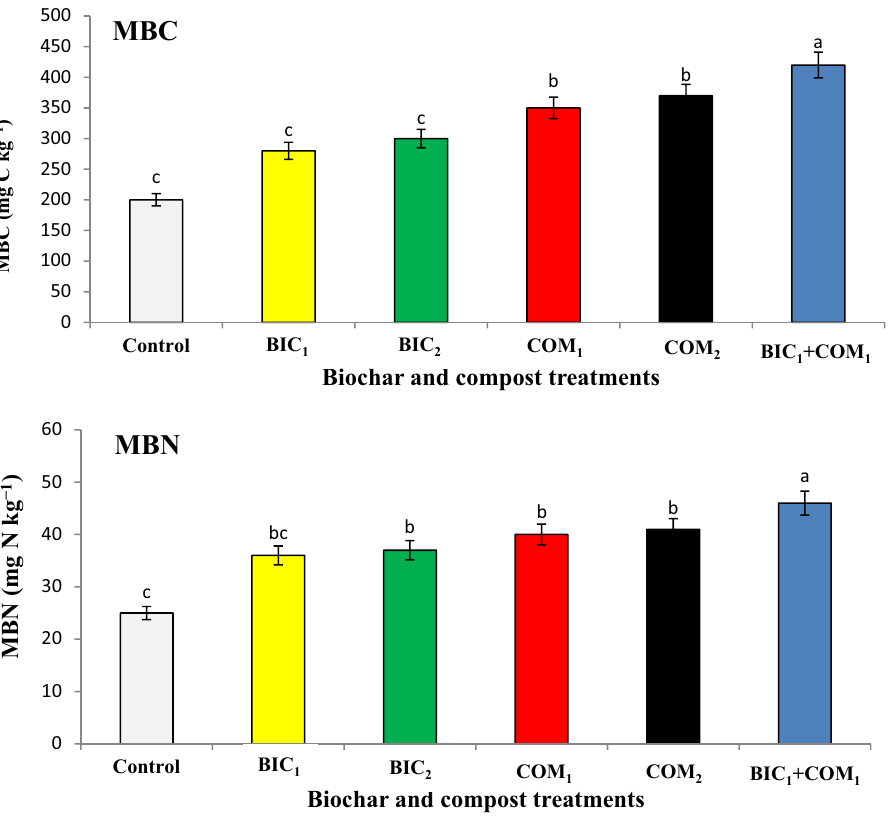
Figure 1. Effect of biochar and compost on soil microbial biomass carbon (MBC) and nitrogen (MBN). BIC 1 and BIC 2 = biochar at rates of 1 and 2% (w/w), COM 1 and COM 2 = compost at rates of 1 and 2% (w/w), and BIC 1 + COM 1 = mixture of the two amendments at 1% (w/w) of each. Means (± SD, n = 5) denoted by the same letter indicate no significant difference according to Tukey’s multiple range tests at p <